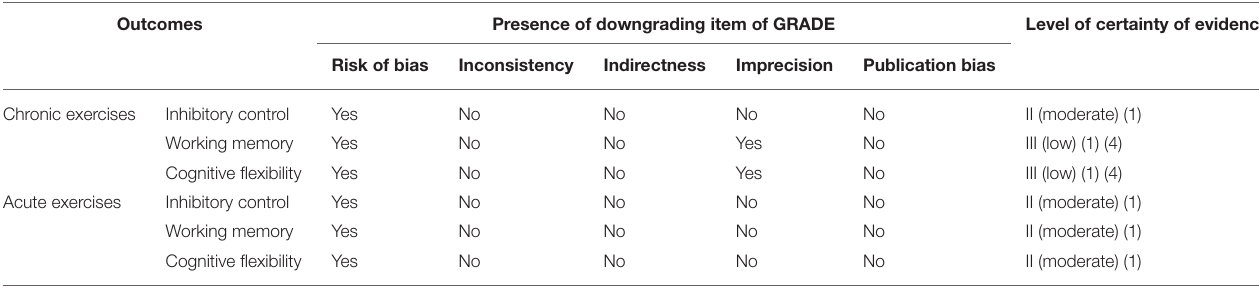
TABLE 4 | Grading Recommendations to Assess Development and Evaluation (GRADE) assessment of the evidence of certainty for exercise effects. Outcomes